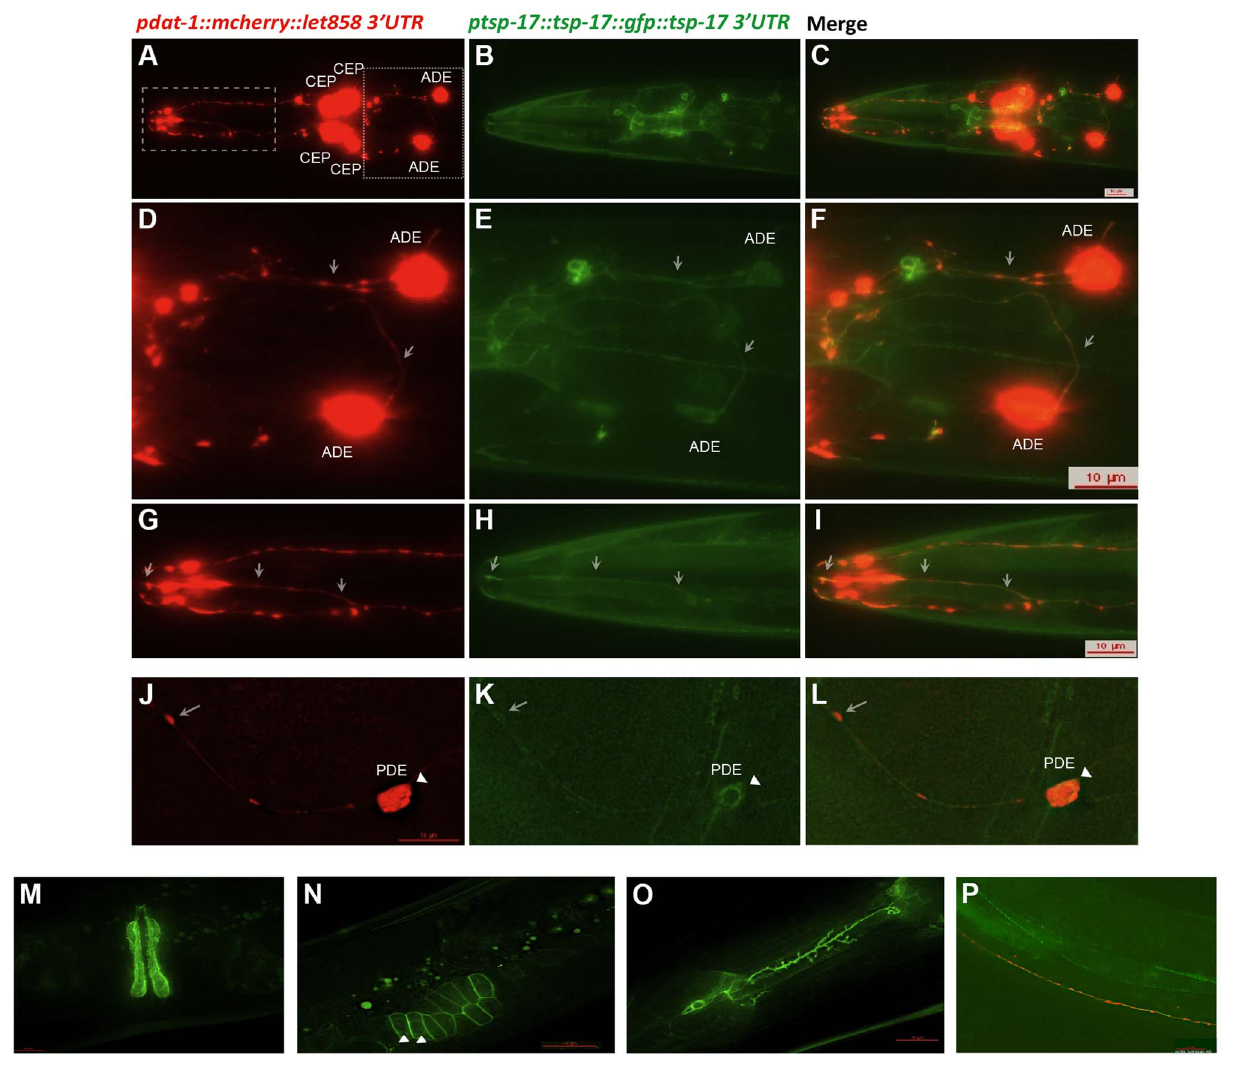
Figure 3. TSP-17::GFP expression. Analysis of the TG2439 strain containing dopaminergic neurons labeled by mCherry and tsp-17 C-terminally fused to GFP and driven by its own promoter. A, D, G, J . Dopaminergic neurons expressing the mCherry marker. Neurons are indicated. White arrows highlight dendrites and axons. B, E. H, K . Expression of TSP-17::GFP. C, F, I, L . Merged images. White arrows highlight dendrites and axons. K, L, N . The arrow-heads indicate TSP-17::GFP signal enrichment around the nucleus. Expression in the vulva ( M ), the spermatheca ( N ), a NSM neuron ( O ), and in body wall muscle cells ( P ).